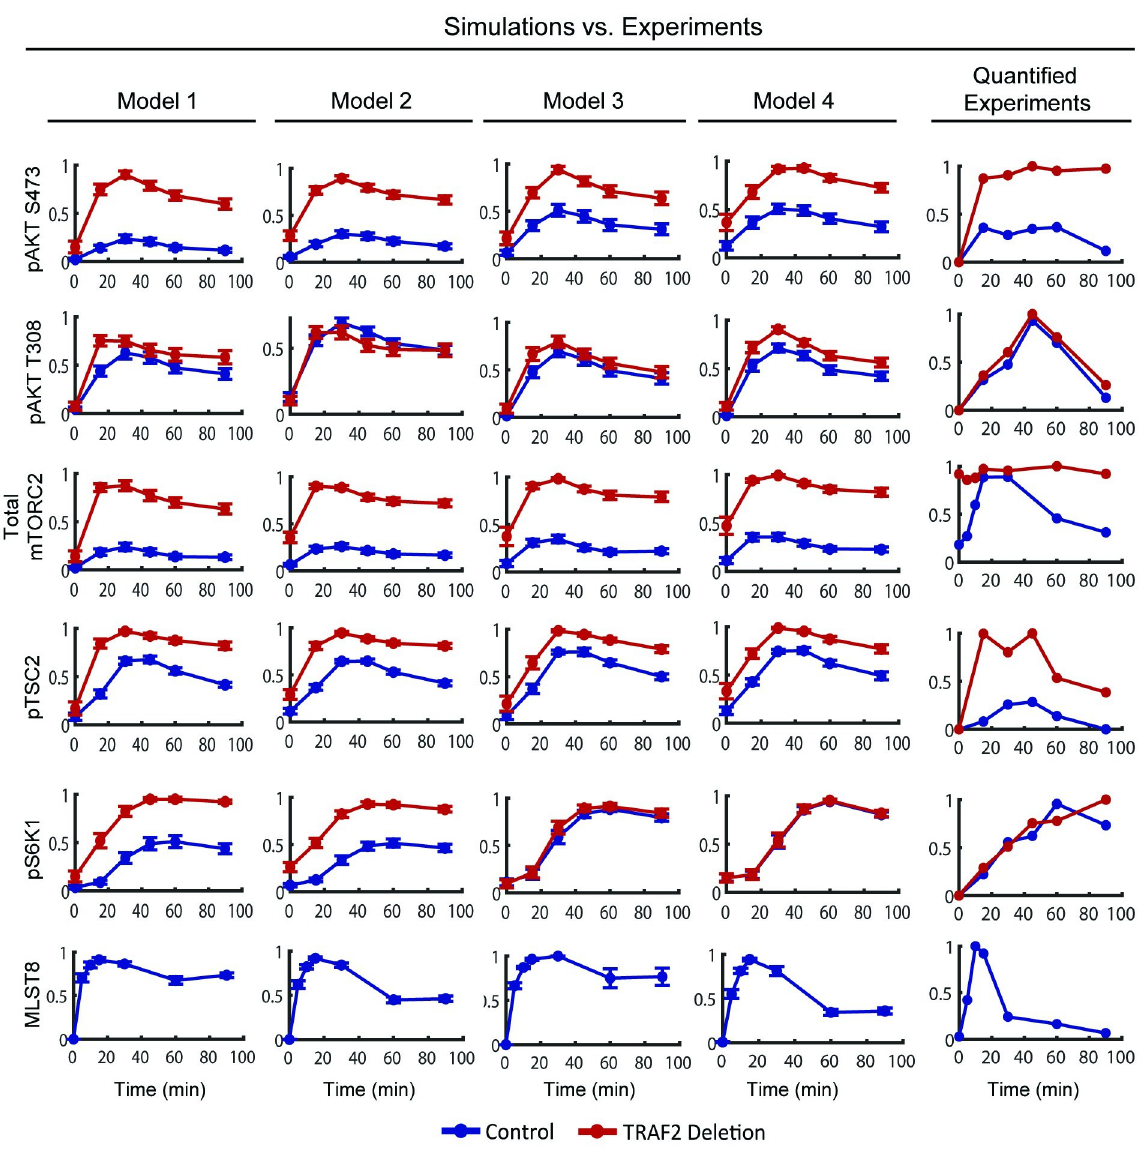
Fig 2. Independent validation of the four models. Simulations of the dynamic response of various network components to insulin stimulation in control (WT MEF cells, blue lines) condition and when TRAF2 is deleted ( TRAF2 -/- MEF cells, red lines), in comparison to the corresponding experimental data (right panels), taken and quantified from [7]. The simulation data are presented as mean ± S.E.M. Experimental data points were reproduced from representative data of at least three biological replicates obtained from [7]. These validation analysis indicates models 1–3 could not recapitulate all data, and model 4 represents the best-fit model (see text for details).